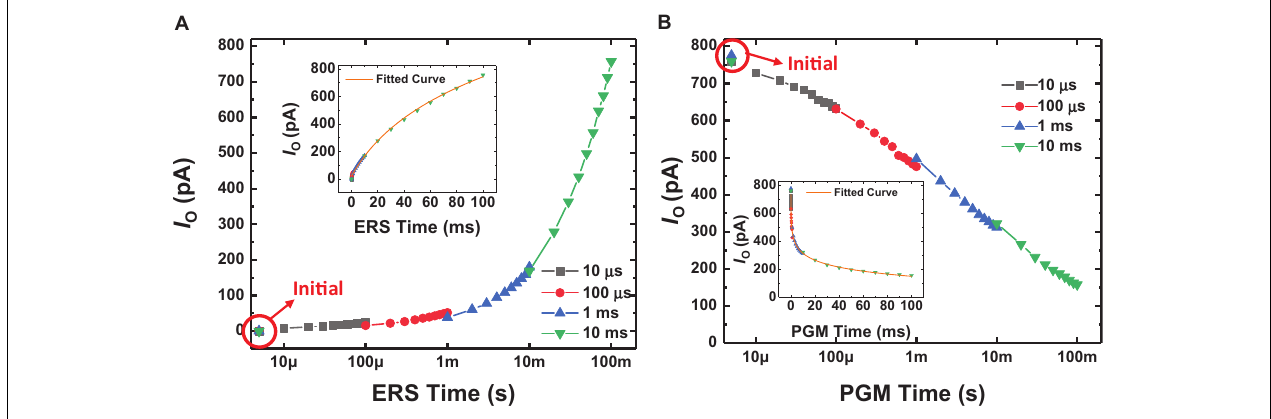
FIGURE 2 | I O behavior with respect to (A) erase time and (B) program time when V O is 3 V and V BG is 0 V. After the GSD is initialized, erase (–7 V) or program (5.5 V) pulses are applied to the BG electrode, with 0 V applied to the S and O electrodes. Each pulse with a different pulse width is applied to the GSD 10 times. (Inset) I O behavior with respect to the erase or program time on a linear scale.